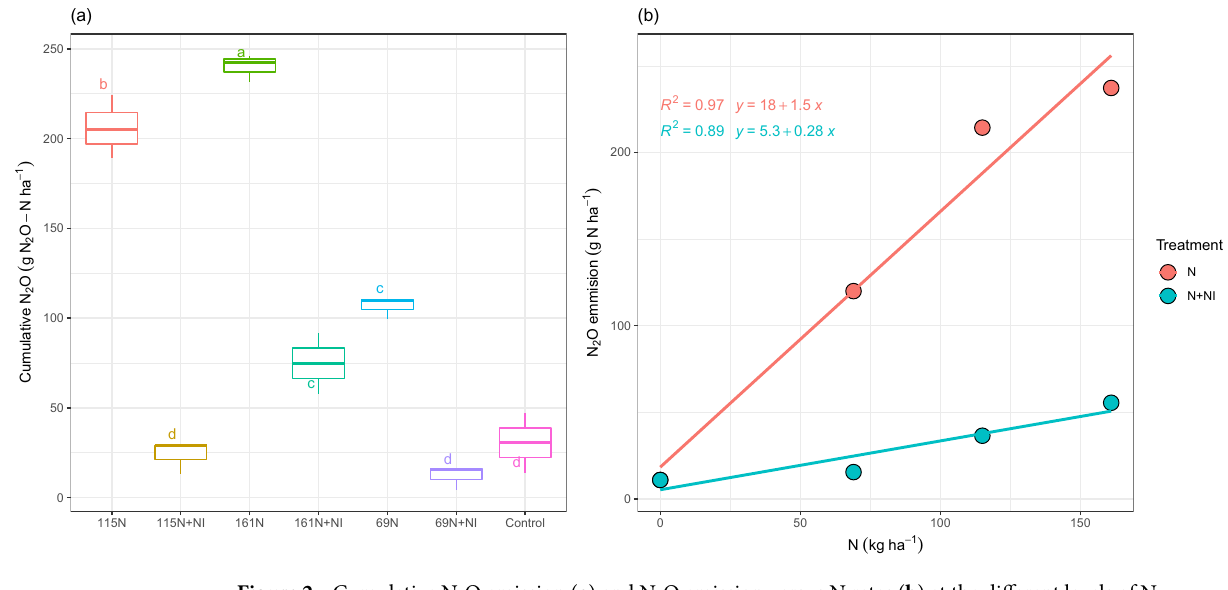
Figure 2. Cumulative N 2 O emission ( a ) and N 2 O emission versus N rates ( b ) at the different levels of N application and with or without NI during the maize growth season in 2018. Means with the same letters are not significantly different according to the least significant difference (LSD) at p < 0.01, n = 3.